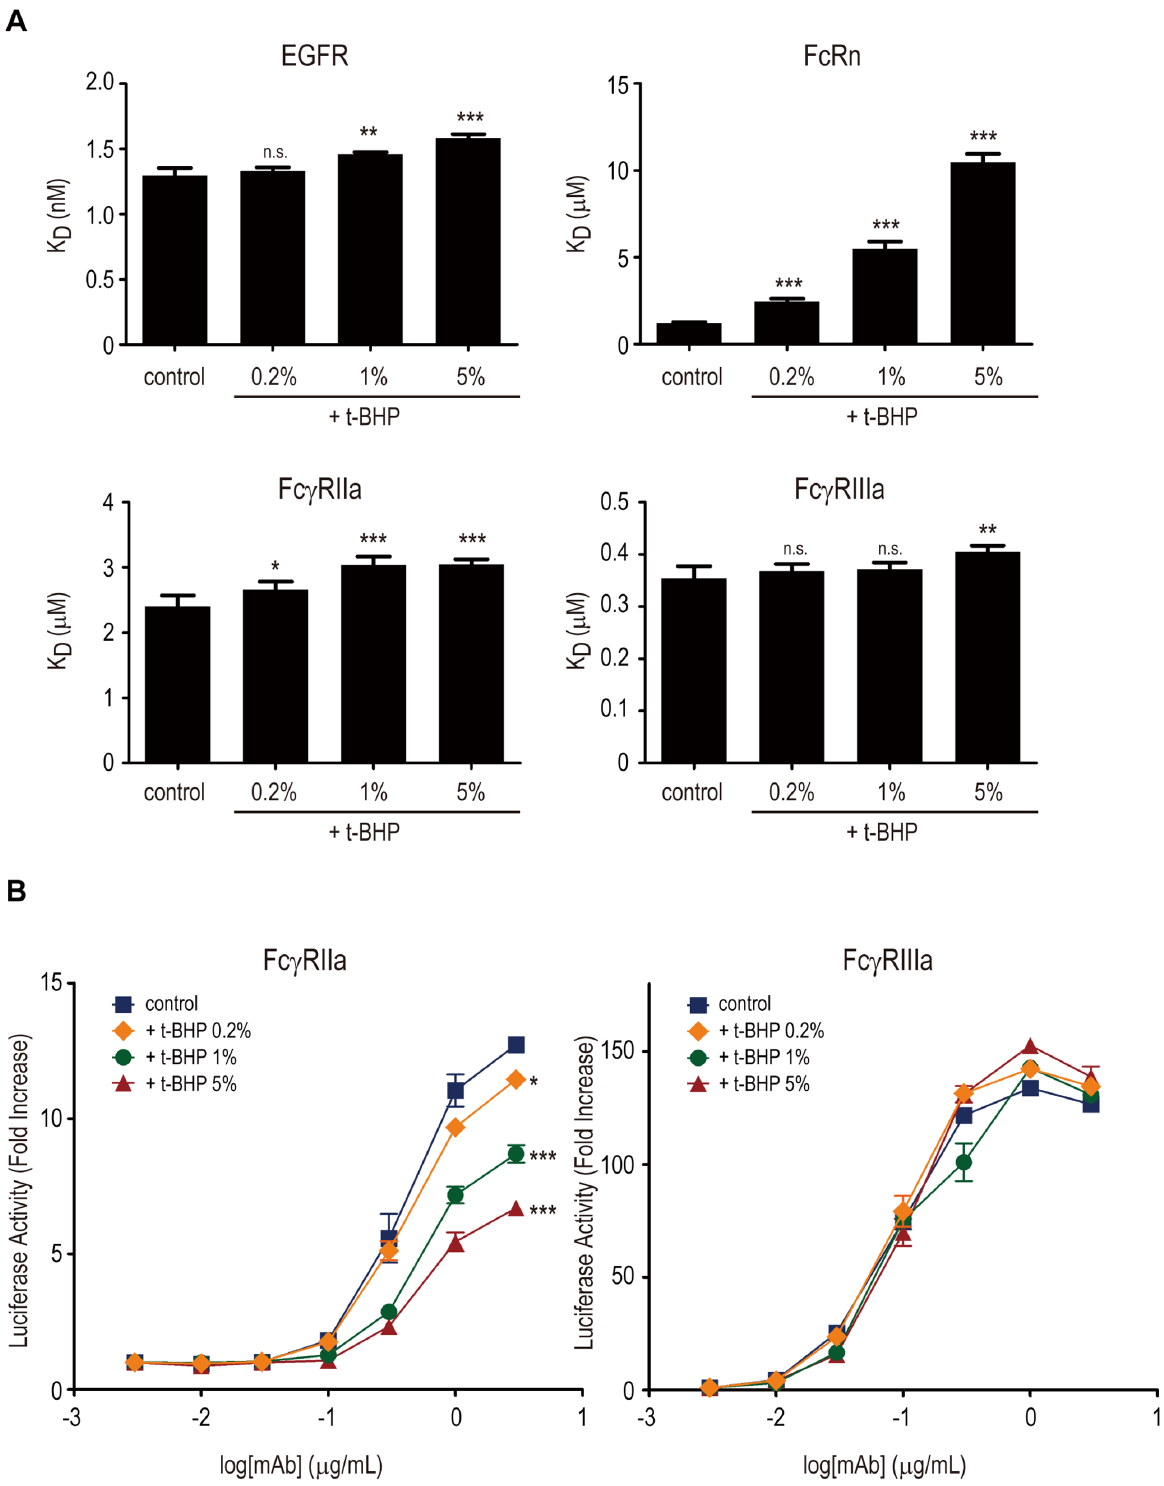
Figure 4. Effects of methionine oxidation on the activation of Fc c RIIa and Fc c RIIIa by cetuximab. (A) Binding affinities of t-BHP-treated cetuximab to EGFR, FcRn, Fc c RIIa and Fc c RIIIa were measured by an SPR analysis. Dissociation constant (K D ) values are represented as mean 6 SD (n=3). *, p , 0.05; **, p , 0.01; ***, p , 0.005; n.s, not significant. (B) Activation of Fc c RIIa and Fc c RIIIa by t-BHP-treated cetuximab was measured by an Fc c R reporter assay using A431 cells as target cells. Methionine oxidation caused by t-BHP treatment dose-dependently decreased the activation of Fc c RIIa (*, p , 0.05; ***, p , 0.005), but not that of Fc c RIIIa (not significant).